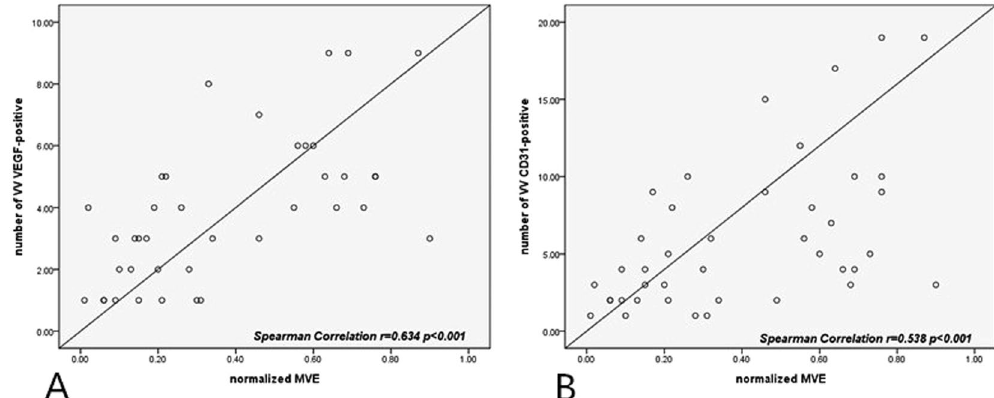
Figure 6. The relationship between the number of VEGF-positive microvessels in the adventitial vasa vasorum and normalized MVE ( A ). The relationship between the number of CD31-positive microvessels in the adventitial vasa vasorum and normalized MVE ( B